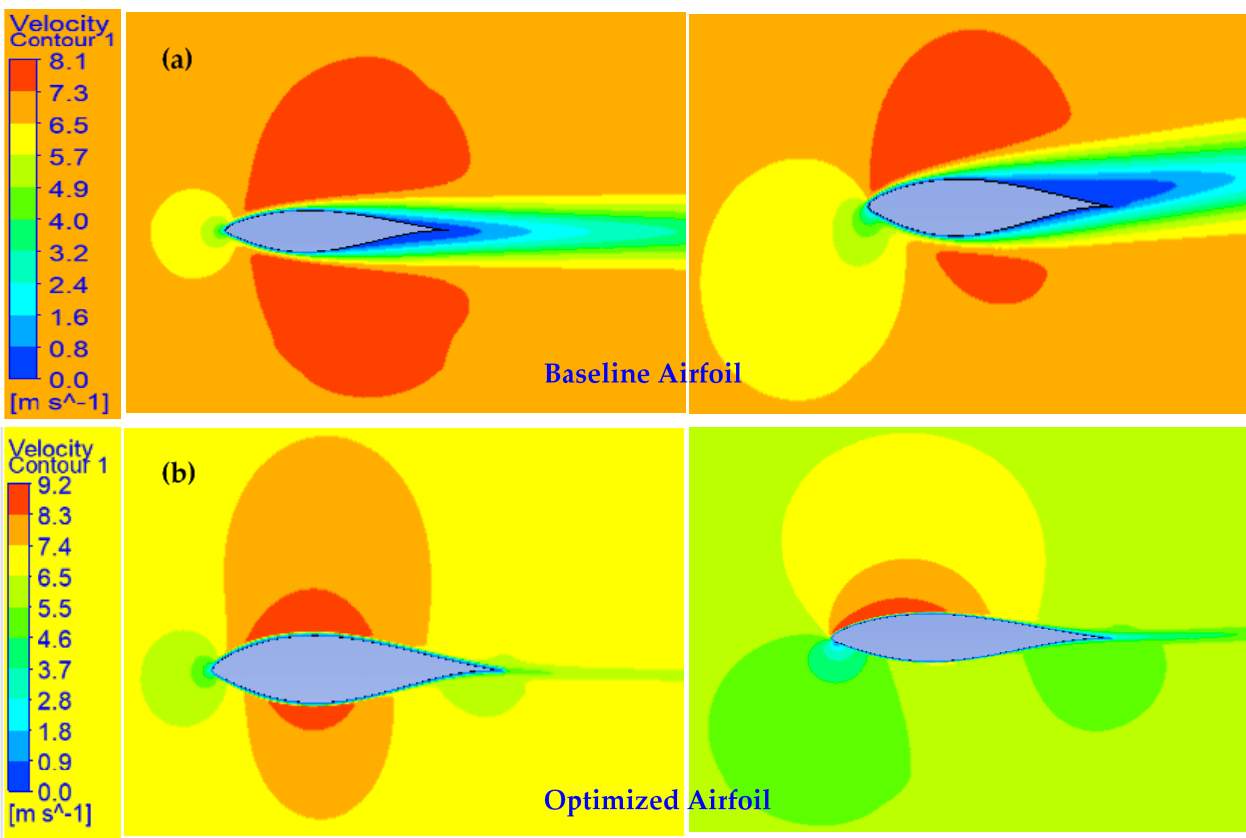
Figure 16. Velocity contour at 0° (left) and 6.2° (right) for the ( a ) baseline S809 airfoil and ( b ) optimized S809 airfoil.